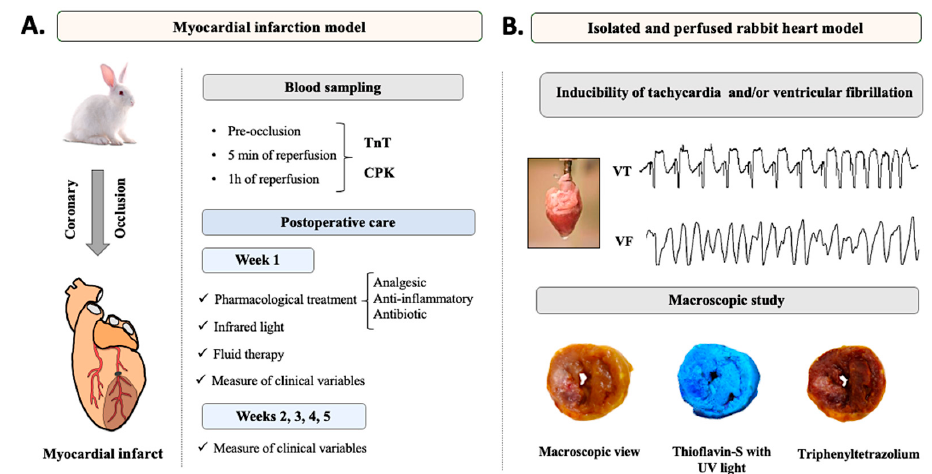
Figure 1. Schematic representation of the experimental design of the present study. ( A ): The chronic experimental procedure of acute myocardial infarction together with the biochemical markers analyzed (troponin T (TnT) and total creatine phosphokinase (CPK)) and a summary of the postoperative care provided during the 5 weeks of the experimental protocol. ( B ): Procedure with isolated and perfused hearts. An electrocardiographic record of induction of a self-limiting ventricular tachycardia (VT) and a ventricular fibrillation (VF) is shown. An example of the stains